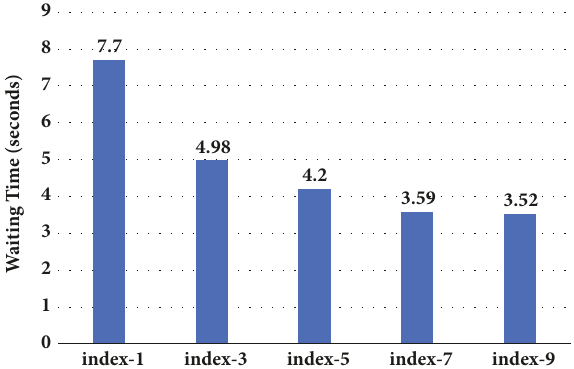
Figure 8: Public transport vehicle;bus; wait times with different site